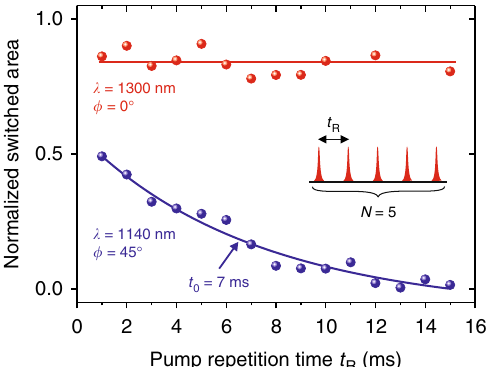
Fig. 5 Photo-magnetic recording in YIG:Co with delay between pump pulses. The study was performed by means of analysis of normalized switched area with N = 5 laser pump pulses as a function of the pump pulse-to-pulse separation time t R . The red solid line is a guide to the eye. The blue solid line was fi tted using exponential function with the characteristic time t 0 = 7